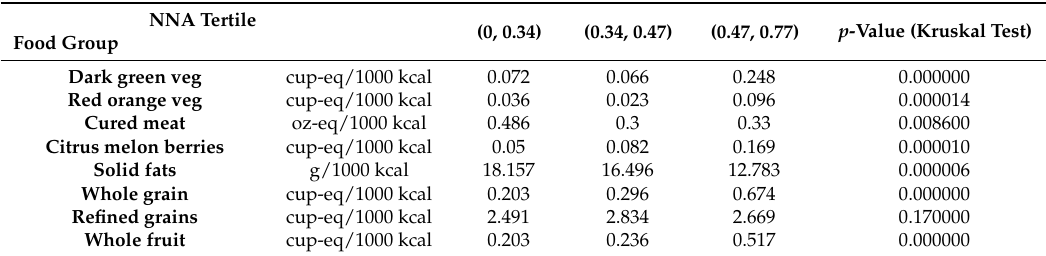
NNA: Nestl é Nutrition